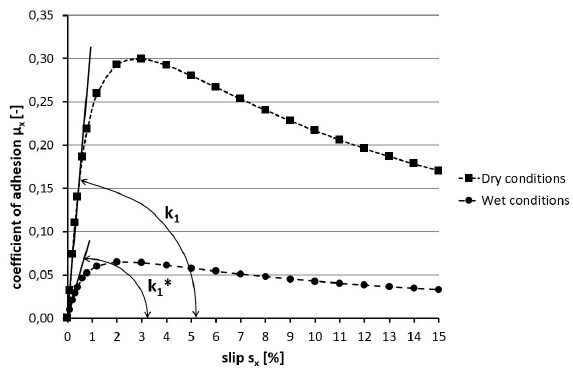
Figure 9. Vehicle traction